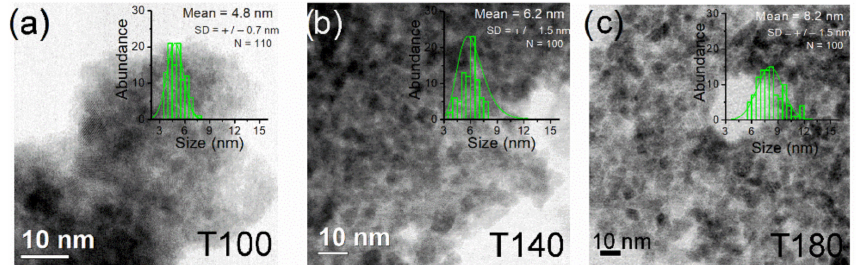
Figure A2. Selected HRTEM micrographs of the particle size evolution as a function of the synthesis temperature, ( a ) 100, ( b ) 140, and ( c ) 180 ◦ C. Insets of each micrograph corresponds to the particle size distribution determined from several images, from N =